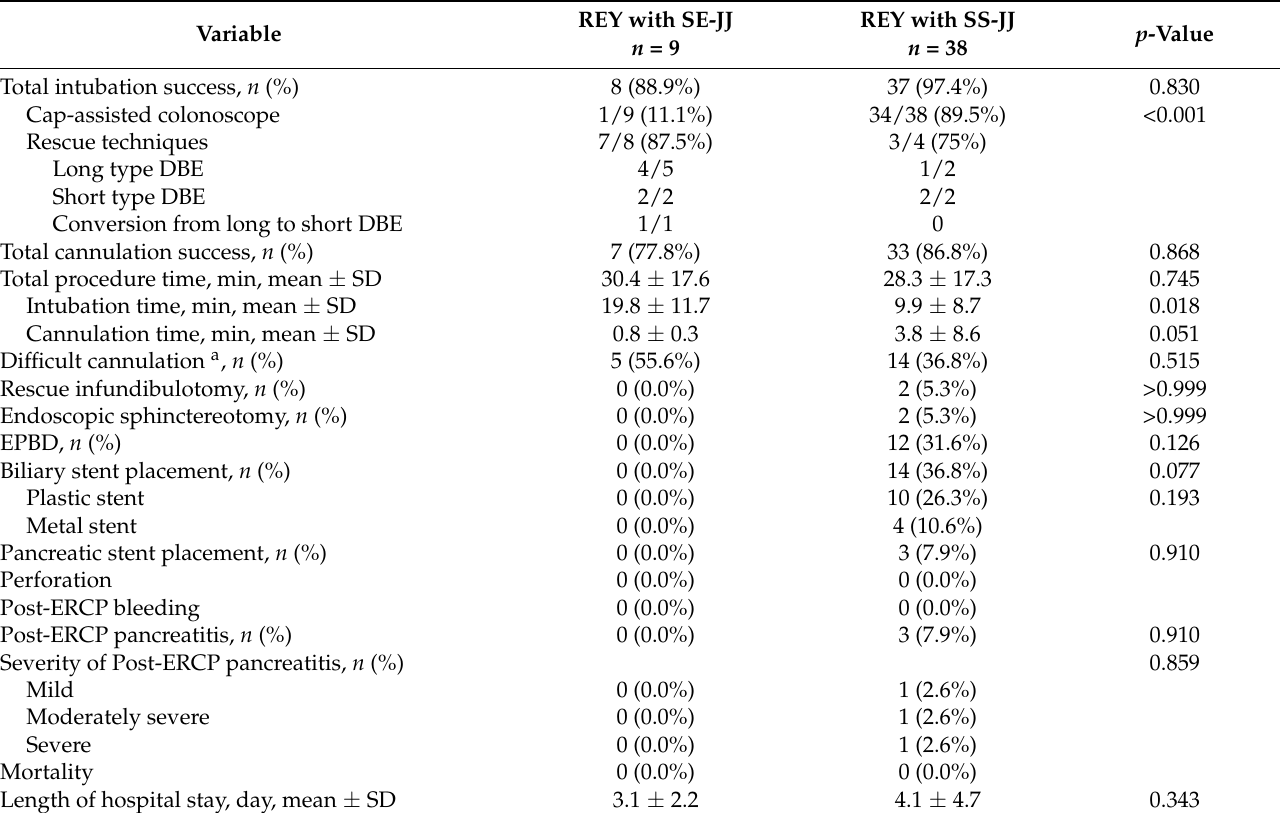
Table 2. Technical and clinical outcomes according to the type of